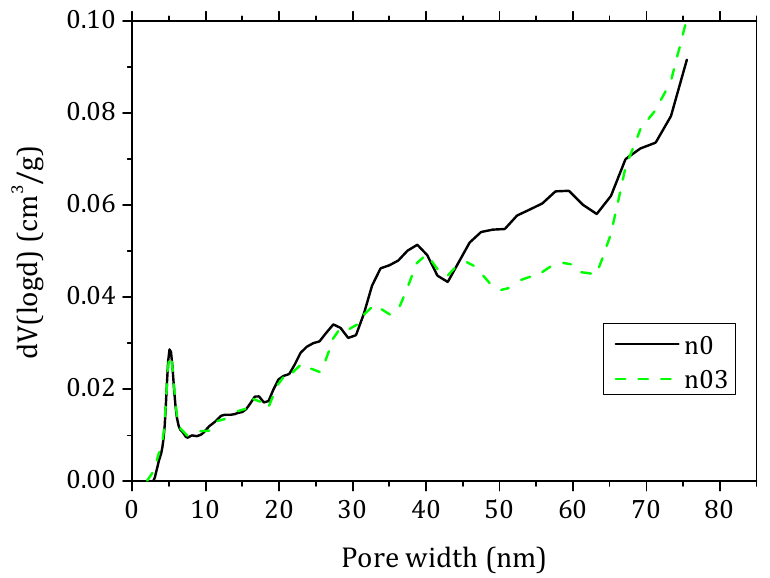
Figure 8. Pore size distribution calculated by DFT method from N 2 adsorption–desorption isotherms for lime pastes with 0% FC (n0) and 0.3% fc (n03).